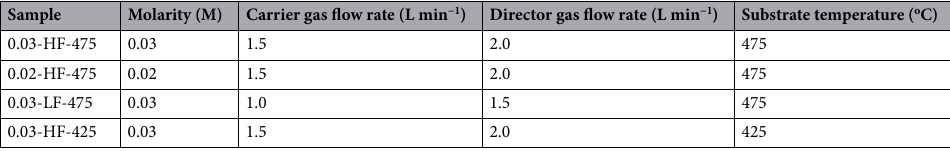
Table 2. Experimental conditions for the deposition of CeO 2 films on glass